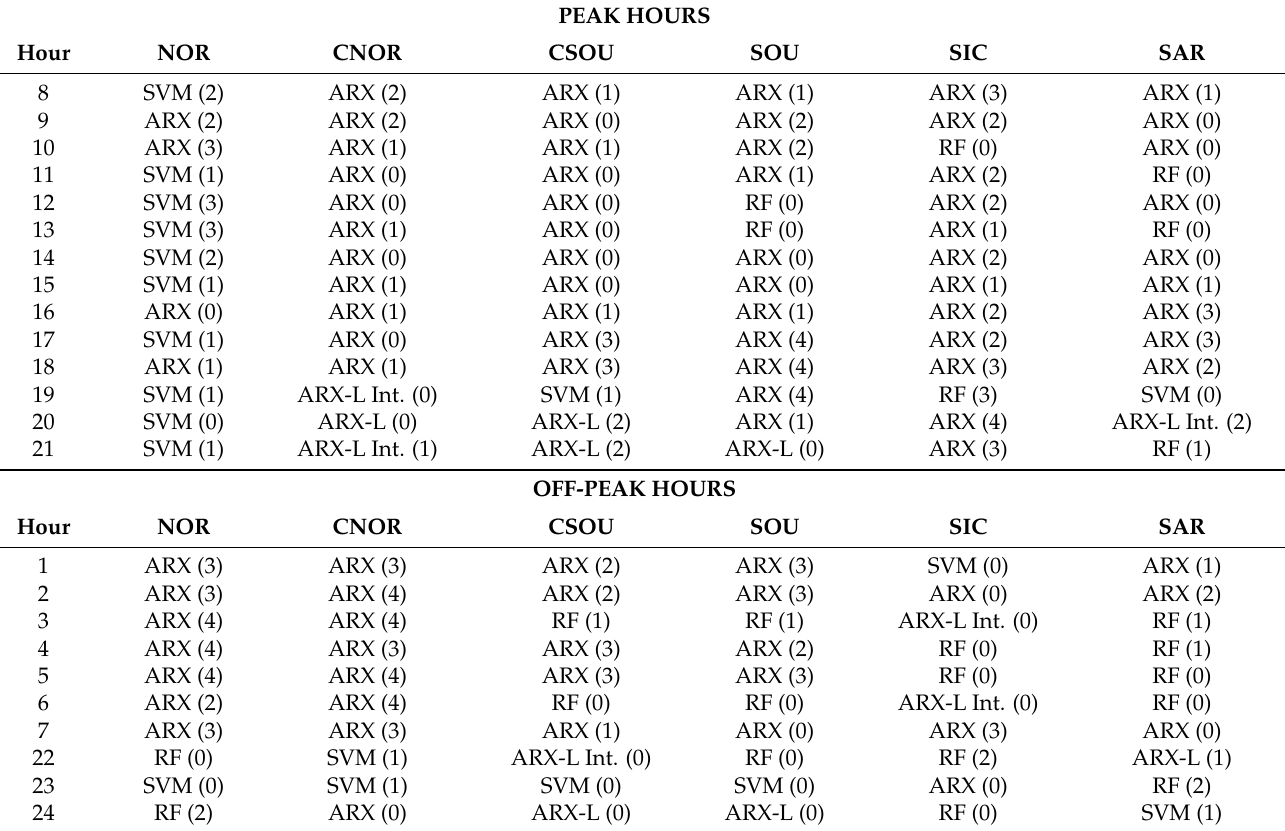
Table 4. Best model according to minimum RMSE—peak and off-peak hours. PEAK